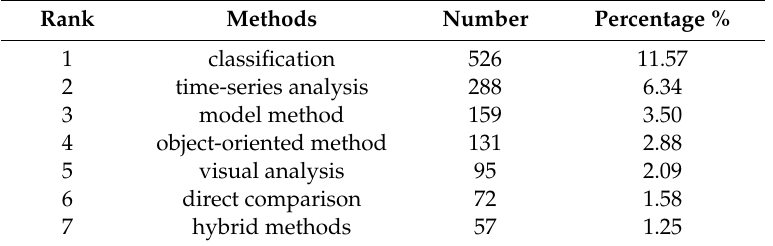
Table 5. The main remote sensing monitoring methods used for protected areas (PAs).